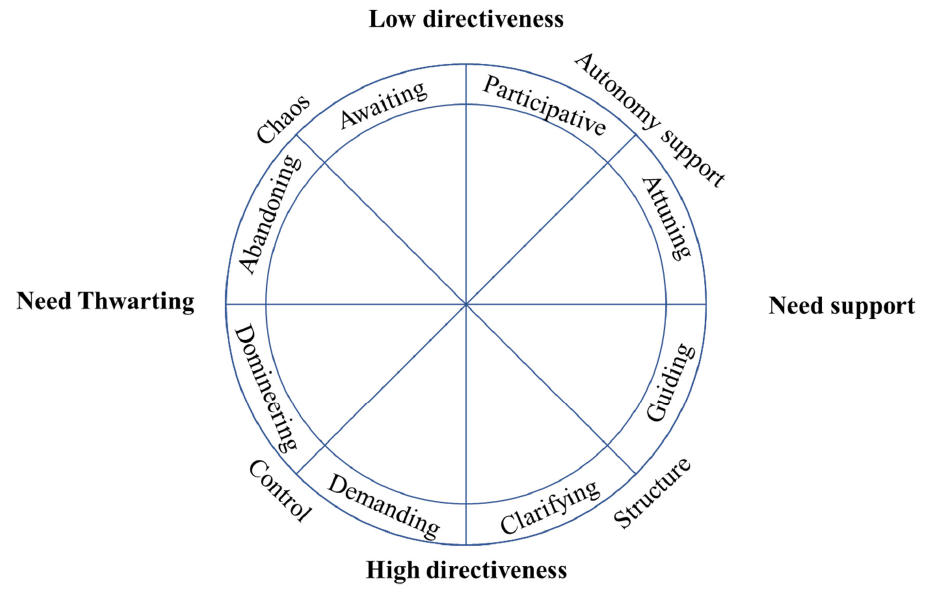
Figure 1. Graphical representation of the circumplex model (Aelterman et al., 2019). 1.1. Need-Supportive Teaching as Presented in the Circumplex Model: Autonomy Support and